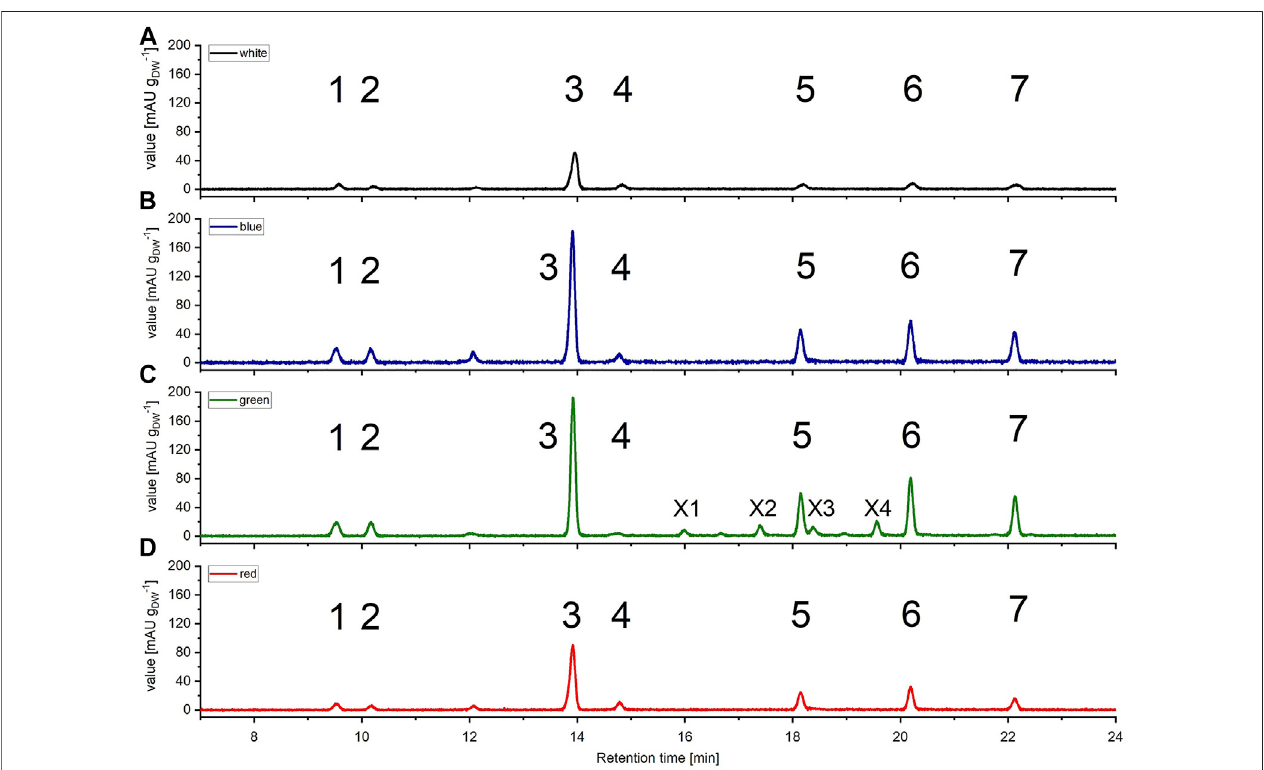
FIGURE 4 | High pressure liquid chromatography (HPLC) spectra of Picochlorum sp. grown at (A) white, (B) blue, (C) green, and (D) red light, harvested at late exponentialphase,at150 μ mol m − 2 s − 1 irradiationlevel.Peaks:1 all-transneoxanthin,2violaxanthin,3lutein,4canthaxanthin,5Chl b ,6Chl a ,7 β -carotene,X1,X2,X3 and X4 unknown pigments (only occurring with green light). Measured on Kinetex 5 µm C8 column (150 mm * 4.6 mm), detection at λ = 450 nm. Known substances were identi fi ed by comparison to commercial standards.